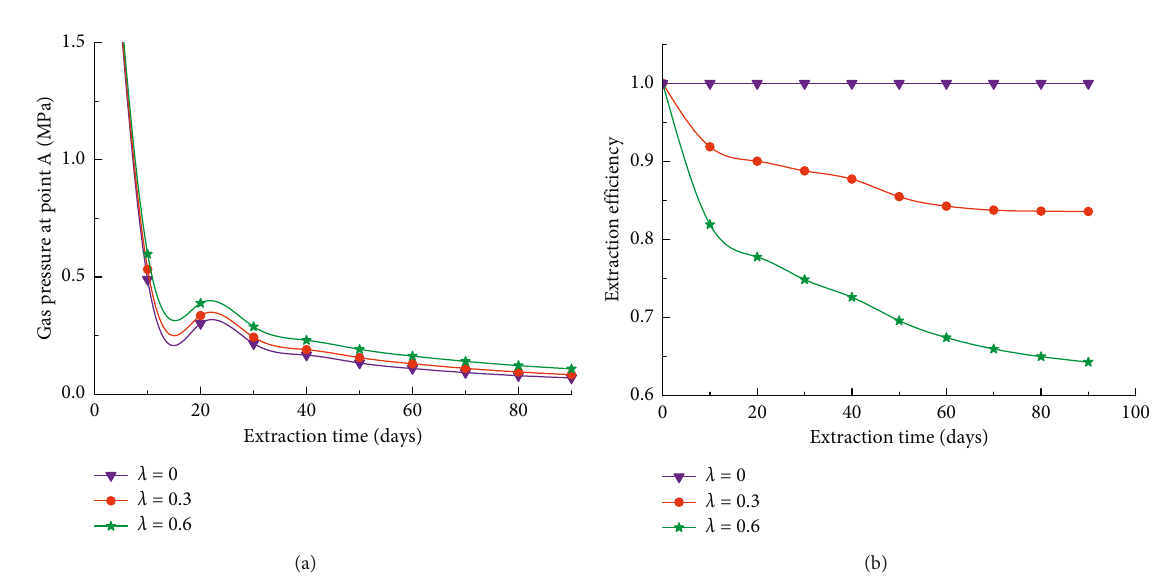
Figure 6: (a) Gas pressure and (b) extraction efficiency at point A for different anisotropic